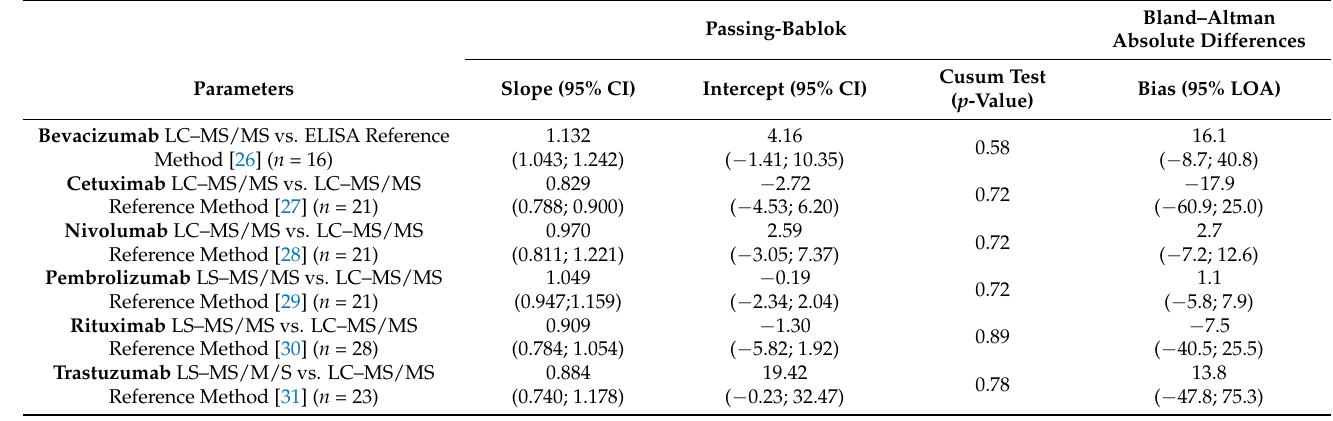
Table 2. Summary of method agreement for each monoclonal antibody (mAb): Estimated parameters and 95% confidence interval (95% CI) of slope and intercept for each monoclonal antibody comparison. p -Value of Cusum test. Mean and 95% limits of agreement (LOA) of bias for each mAb comparison.